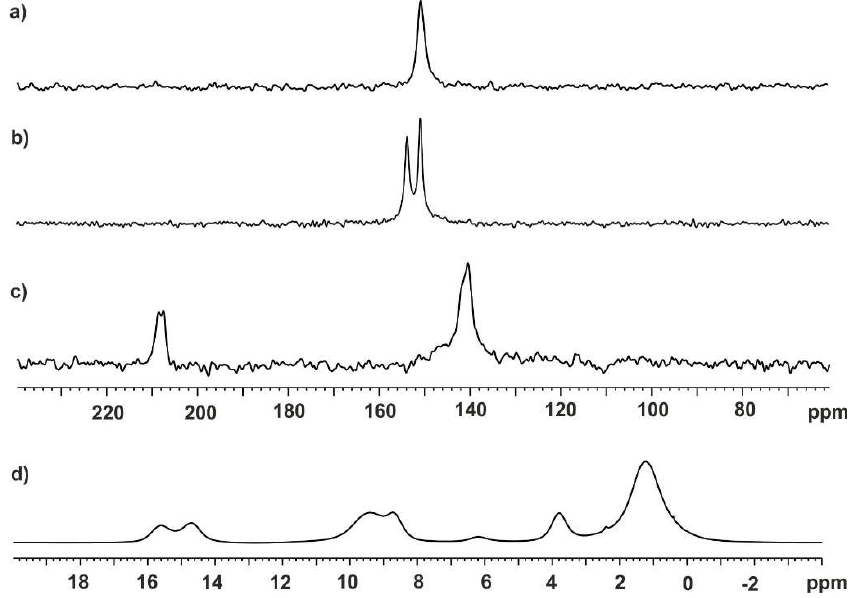
Figure 9. 15 N CP / MAS Spectra recorded with a spinning rate of 8 kHz for ( a ) barbituric acid; ( b ) barbituric acid dihydrate; ( c ) HIMO and BA in a ratio of 1:1 after 2 h of grinding; ( d ) 1 H VF / MAS spectrum recorded with a spinning rate of 60 kHz for HIMO and BA in a ratio of 1:1 after 2 h of grinding.